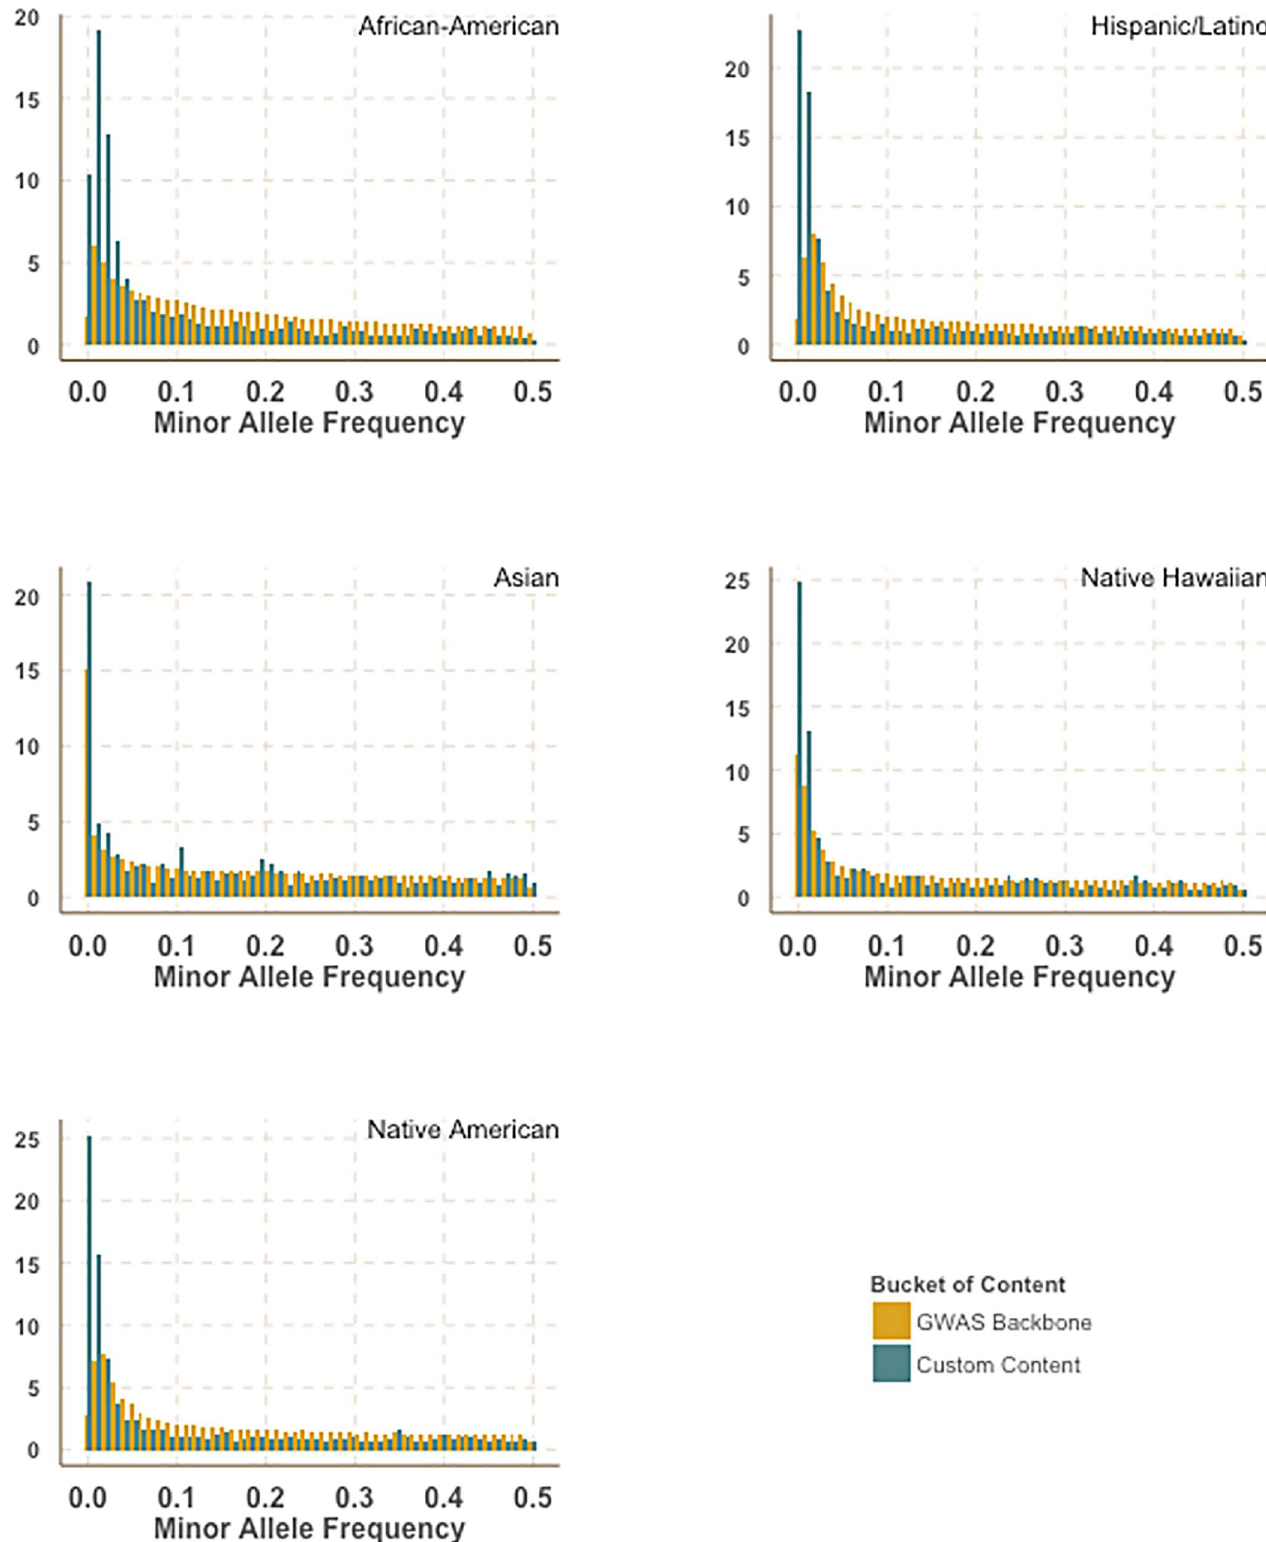
Fig 1. Enrichment of rarervariation in custom content. Comparisonof minor allelefrequency distribution betweenthe MEGA GWAS backbone and the custom content stratified by race. Allele frequencieswere calculatedin PAGE II study populations. doi:10.1371/journal.pone.0167758.g001 PLOS ONE | DOI:10.1371/journal.pone.0167758 December14,